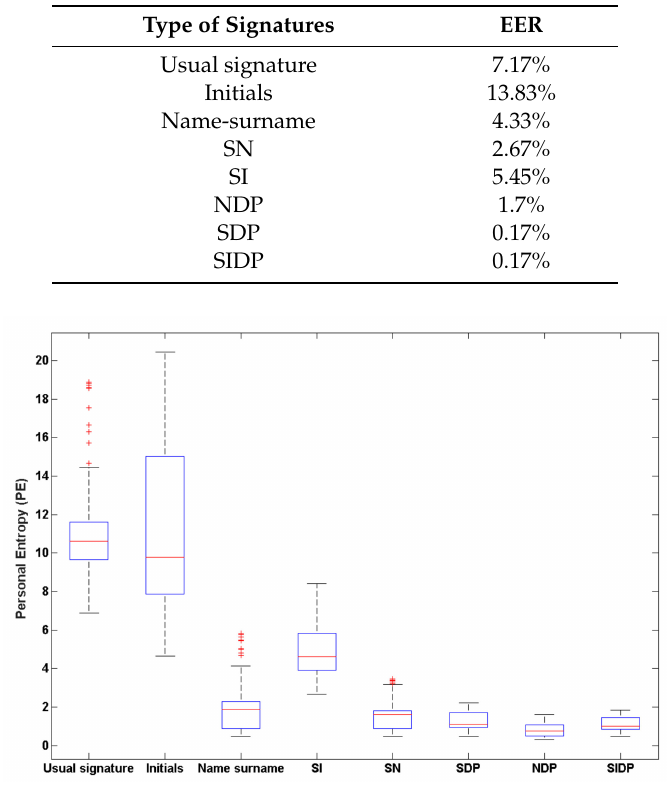
Figure 12. Boxplots of PE values per signature type for users of the highest PE